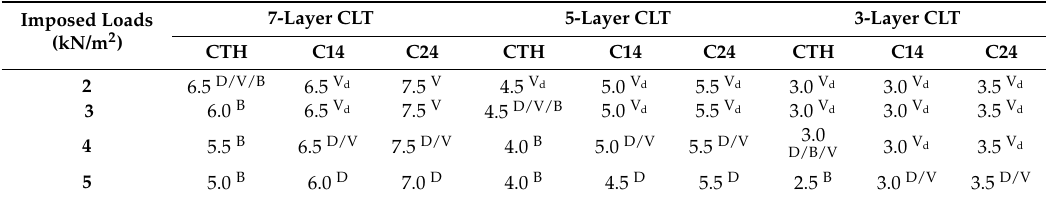
Table 3. Maximum span (m) for the different strength classes, loads, and number of layers. Imposed Loads (kN/m 2 )